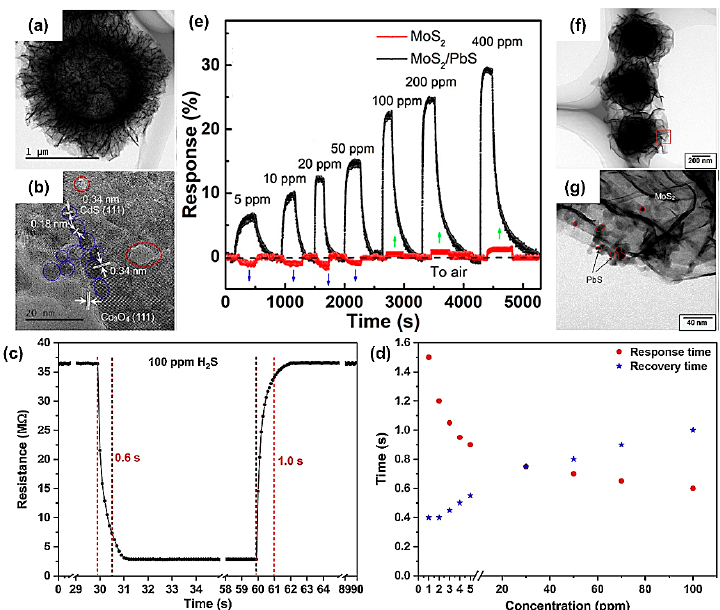
Figure 12. ( a , b ) TEM and HRTEM images of CdS QD/Co 3 O 4 synthesized by in situ growth method at 25 °C. Performance of the CdS QD/Co 3 O 4 sensor: ( c ) The response curve of the sensor to 100 ppm H 2 S at 25 °C, ( d ) Response and recovery times of the sensor to H 2 S at concentrations ranging from 1 to 100 ppm. Reprinted with permission from Ref. [36]. Copyright 2019, Elsevier. ( e ) Dynamic response–recovery curves of MoS 2 and MoS 2 /PbS gas sensors without a heating device at 5–400 ppm NO 2 concentrations. ( f , g ) TEM images of MoS 2 /PbS composites. Reprinted with permission from Ref. [124]. Copyright 2019, American Chemical Society.